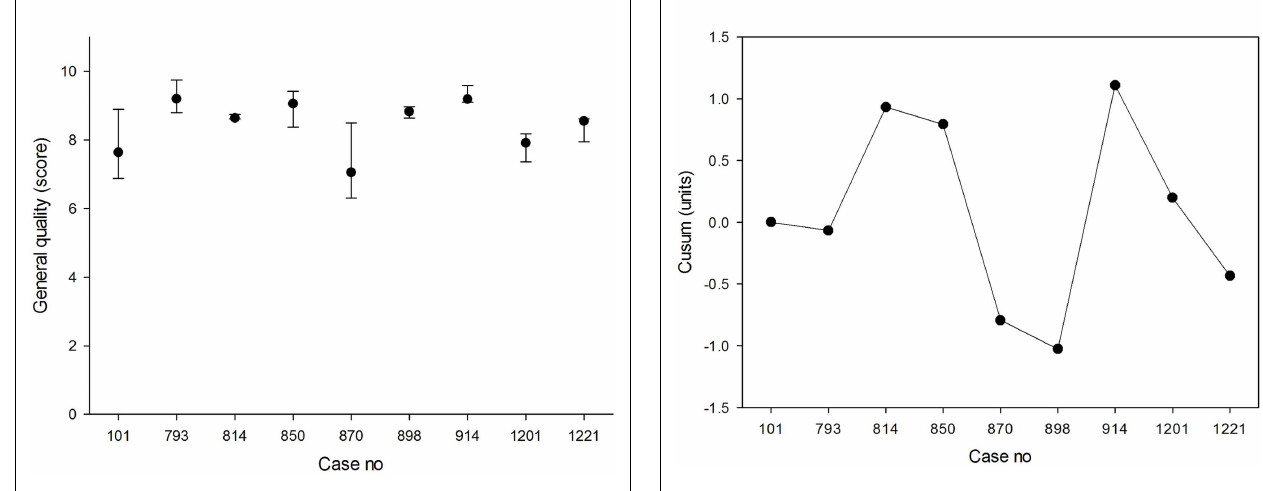
FIGURE 5 | Median scores for general quality (0 = worst; 10 = best) .The error bars indicate the 25th and 75th percentiles.